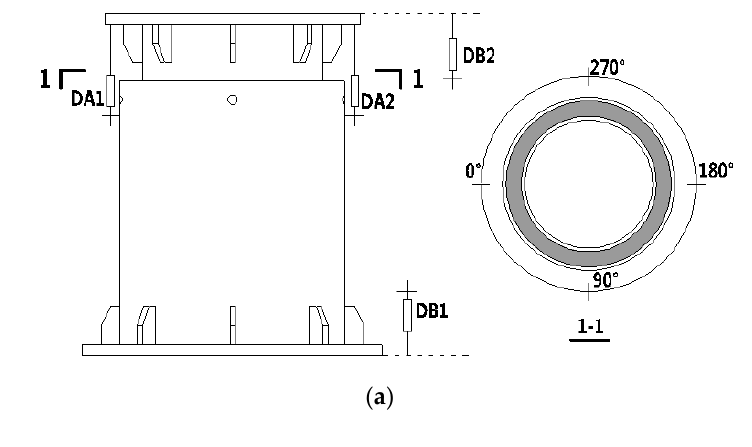
Figure 9. Schematic diagram of test points arrangement of grouted connection.